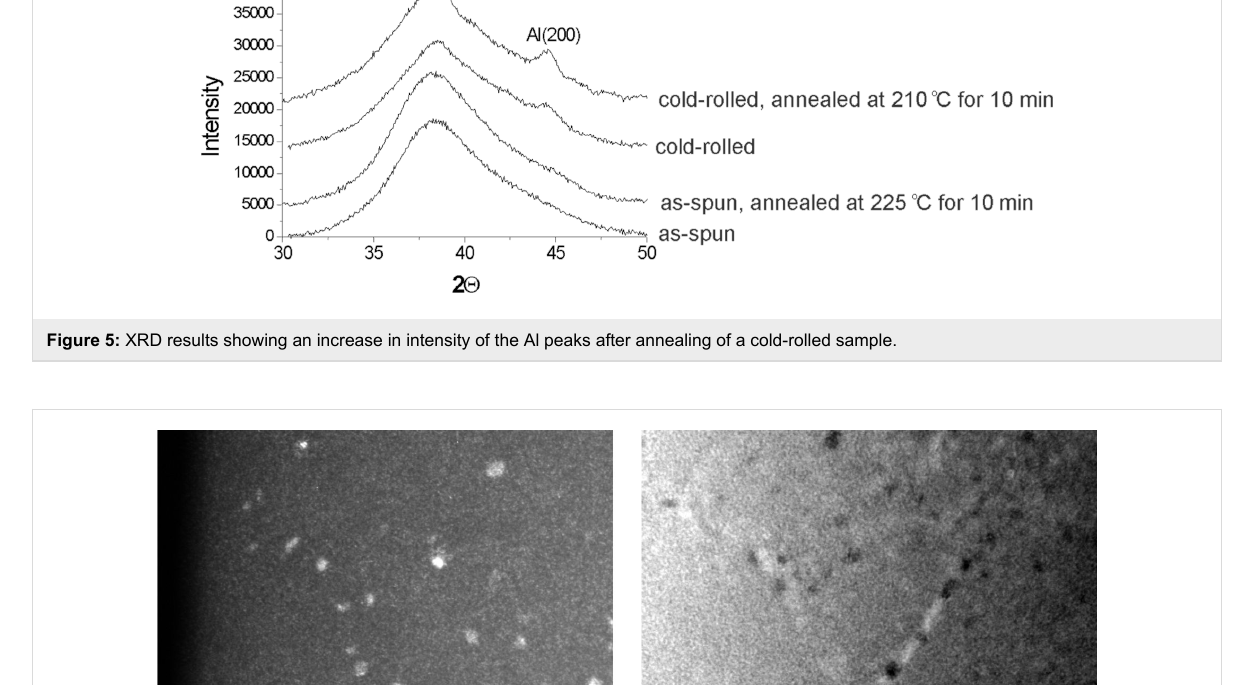
The combination of HRTEM, DF-TEM, XRD, and DSC results provides strong evidence that cold-rolling does promote crystal- lization outside shear bands at annealing temperatures that are insufficient to induce crystallization for undeformed